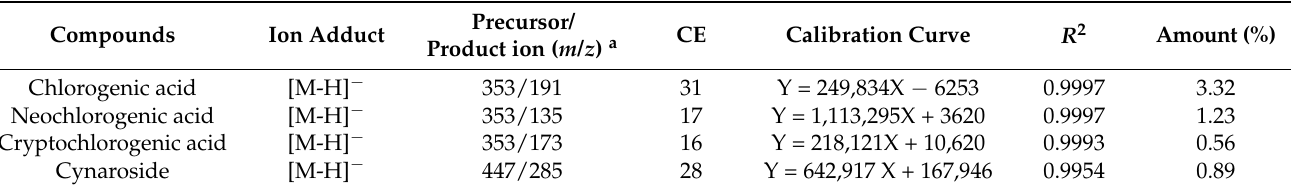
Table 2. Establishment of the LC-MS/MS analysis methods of the selected compounds from